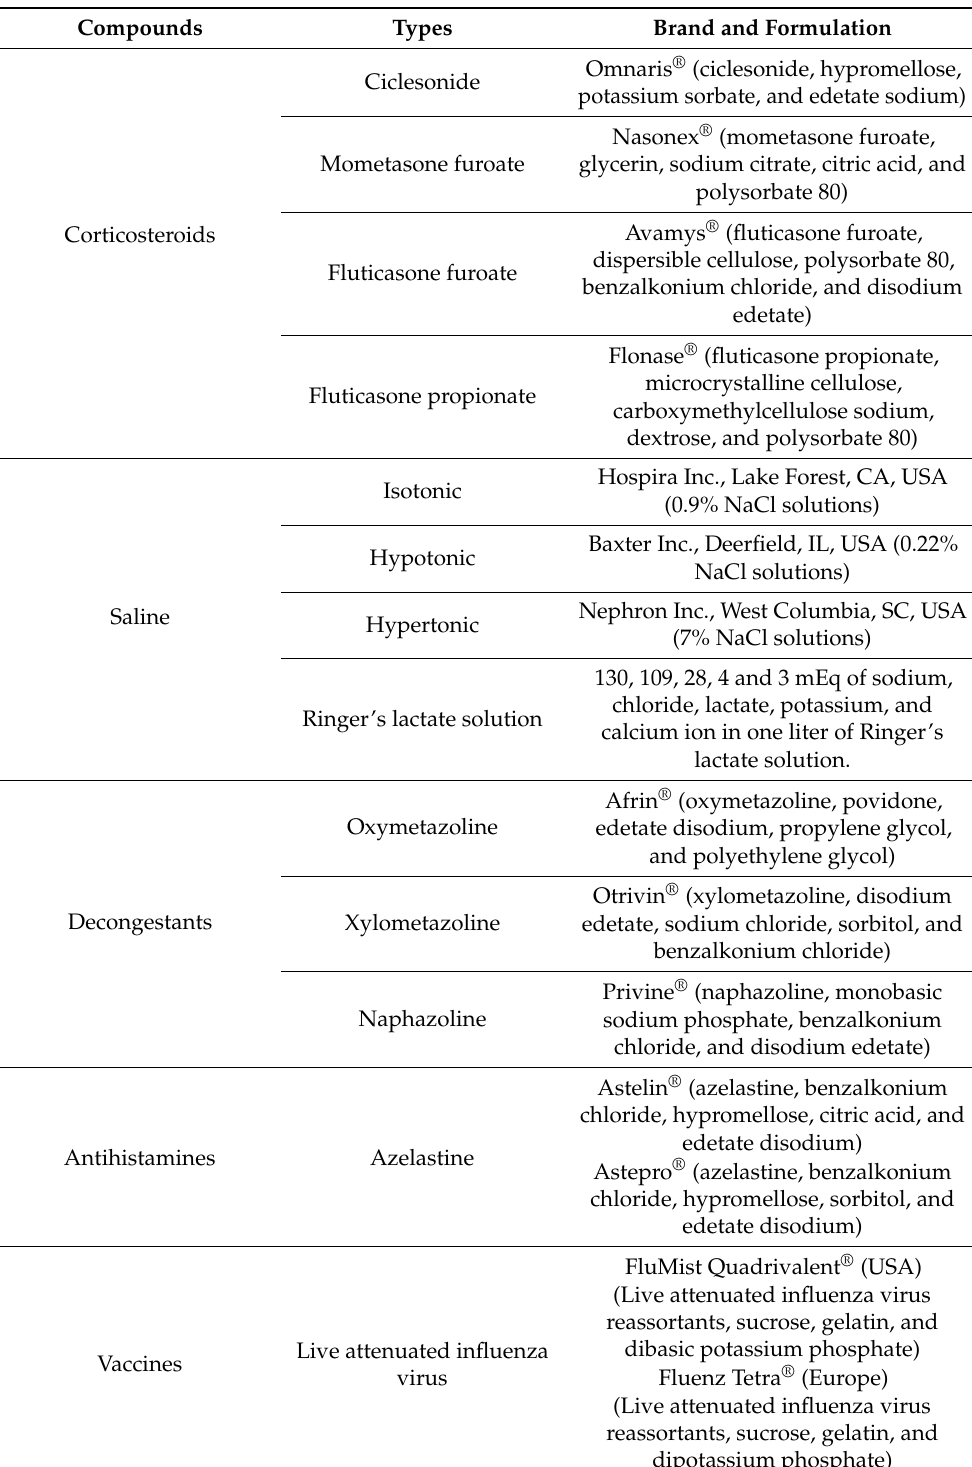
Table 2. Commonly administered drugs via the nasal route of